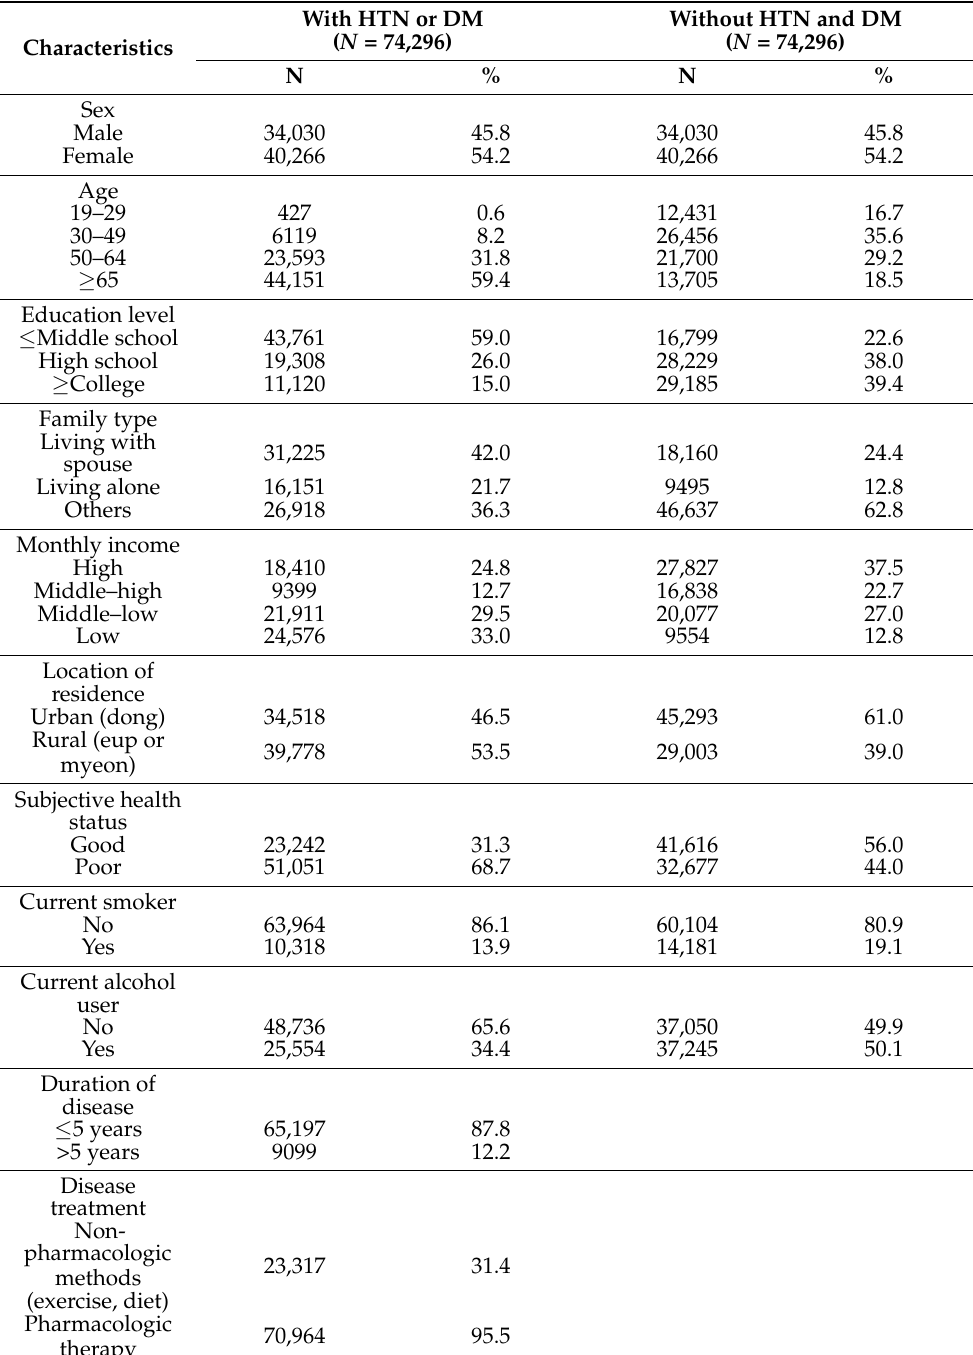
Table 1. Characteristics of adults with HTN or DM and